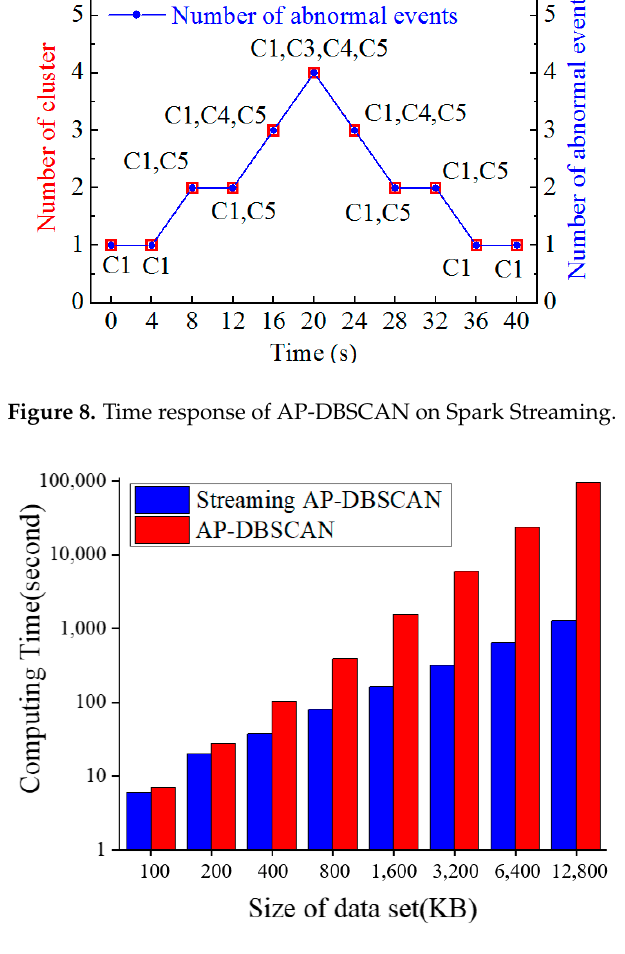
Figure 9. Computing times by AP-DBSCAN and AP-DBSCAN on Spark Streaming.